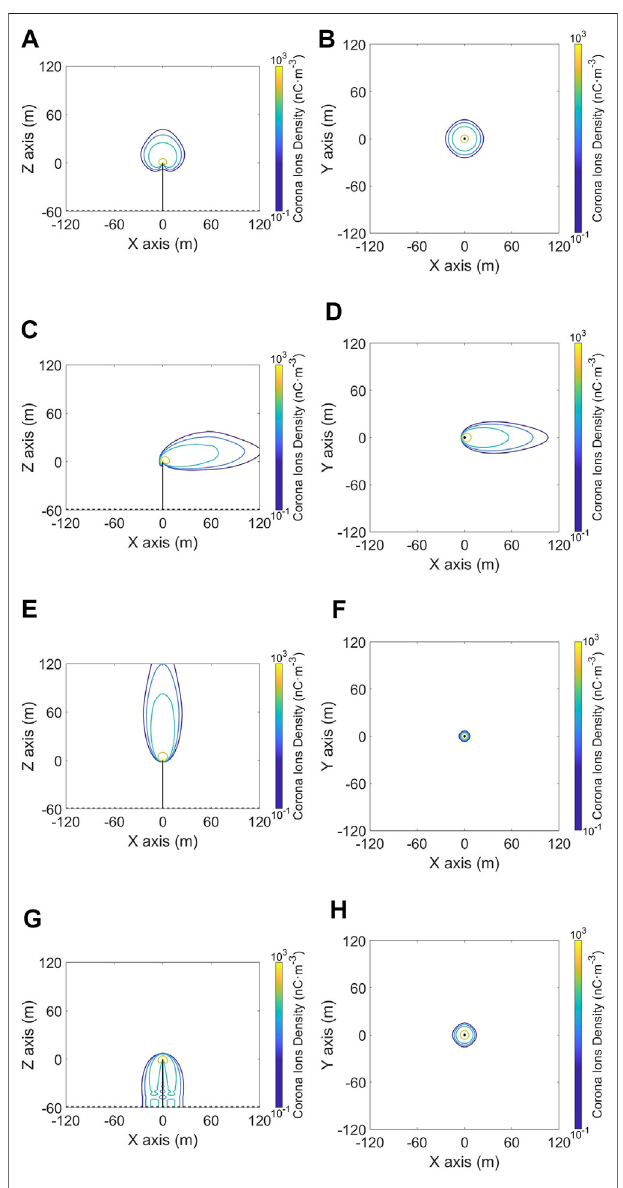
FIGURE 5 | Contours of the density of corona charges produced at the tip of a 60-m rod when the thunderstorm background E- fi eld reached its maximum value (20 kV/m). The results are given in the case of no wind (A,B) , horizontal wind (C,D) , updraft (E,F) , and downdraft (G,H) . The side views are given to the left and the top views to the